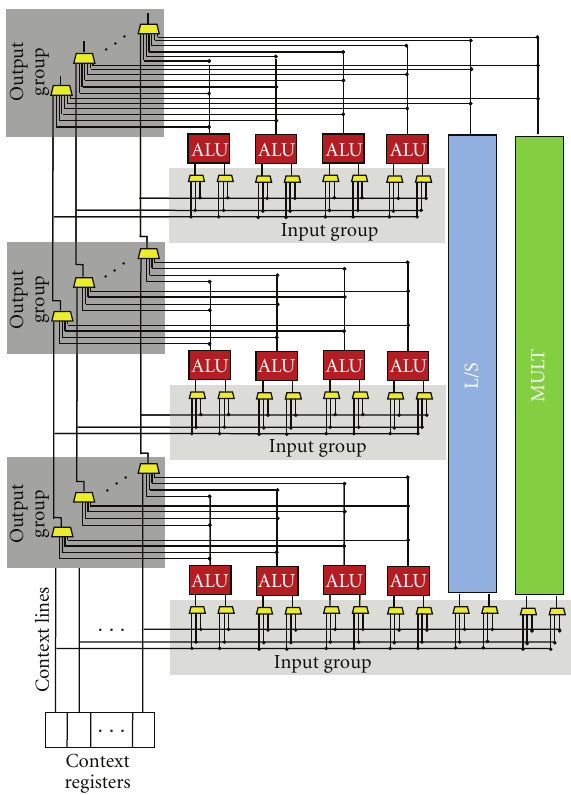
Figure 3: FAT-array interconnection model based on multiplexers and buses.